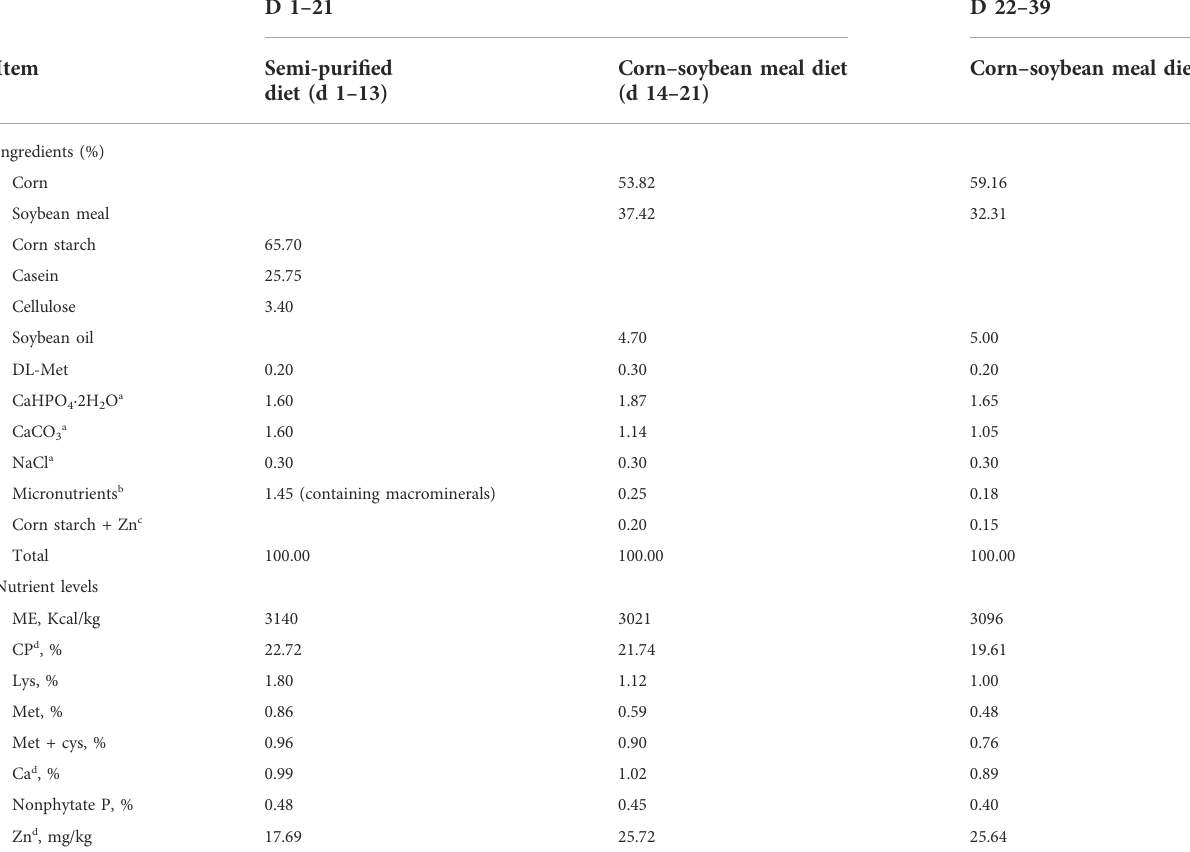
TABLE 1 Composition and nutrient levels of the basal diets for 1- to 39-day-old broilers (as-fed